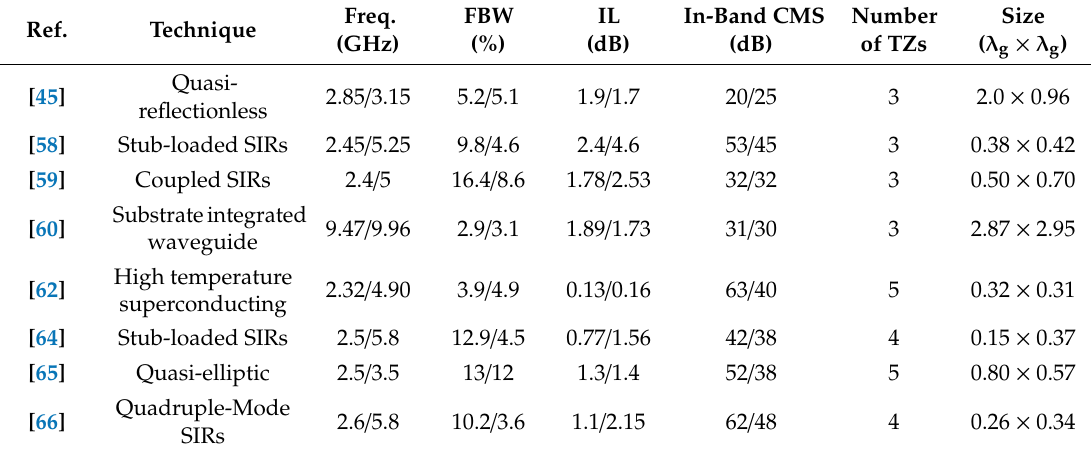
Table 2. Performance comparisons for some recent dual-band di ff erential microstrip BPFs.